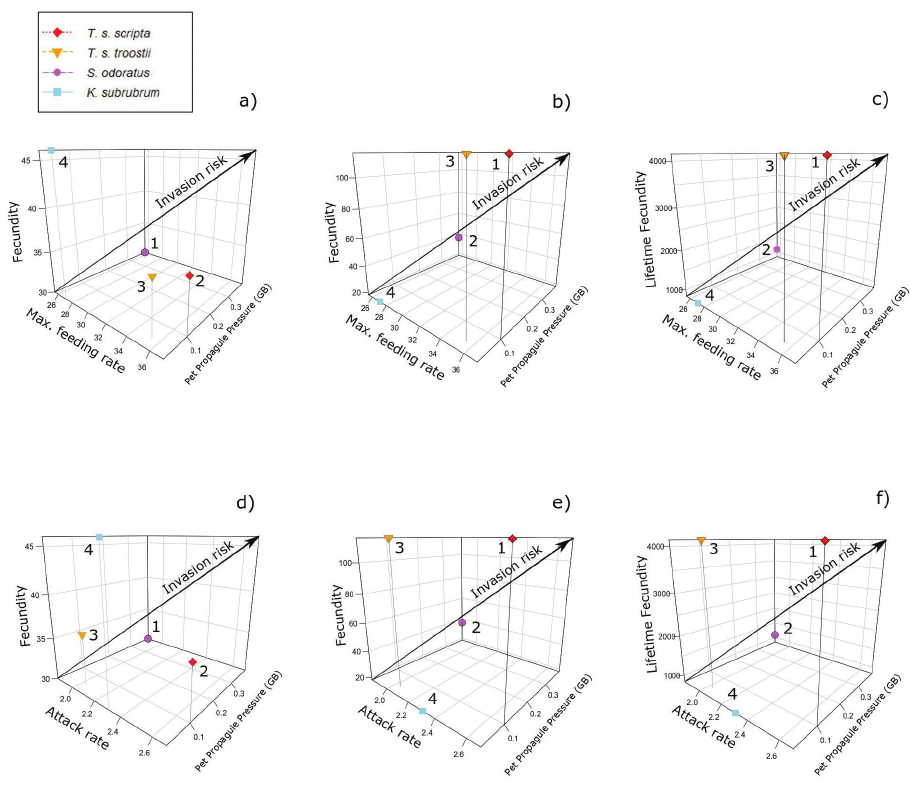
Figure 5. Triplots showing Relative Invasion Risk of T. s. scripta , T. s. troostii , S. odoratus and K. subru- brum in a Great British context. Invasion Risk is calculated as a product of maximum feeding rate, lifespan and Pet Propagule Pressure (PPP) ( a ), with fecundity ( b ) and with lifetime fecundity ( c ); then attack rate, lifespan and PPP ( d ), with fecundity ( e ) and with lifetime fecundity ( f ). PPP for each species calculated by surveying classified advertisements online and finding what proportion were selling the species in ques- tion. Invasion Risk increases from bottom left to top right of each plot, with species ranked